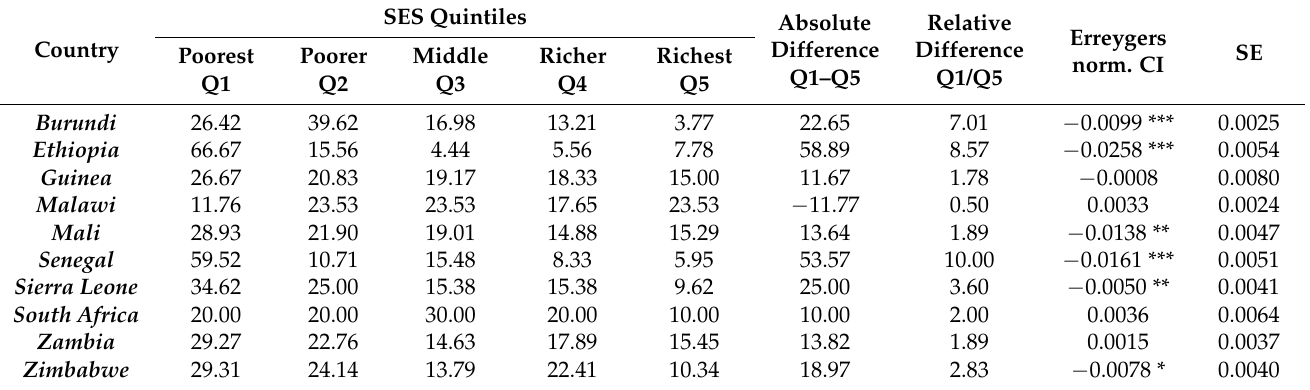
Table 4. Estimated prevalence of wasting among children by socio-economic status (SES) quintile.